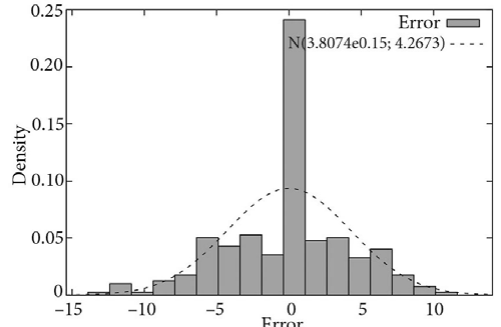
Fig. 6. Histogram of standard errors (graphical presentation of the Chi -square Goodness-of-Fit